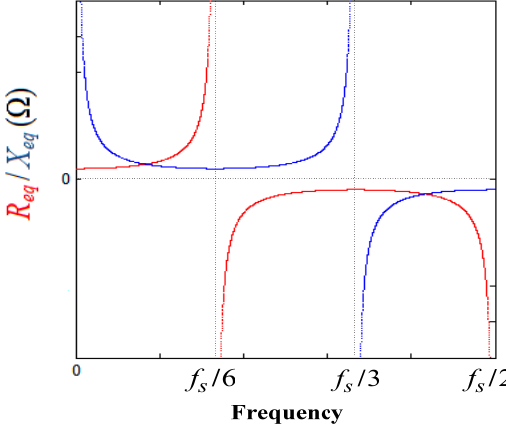
Figure 9. Curves of R eq and X eq as the function of frequency.